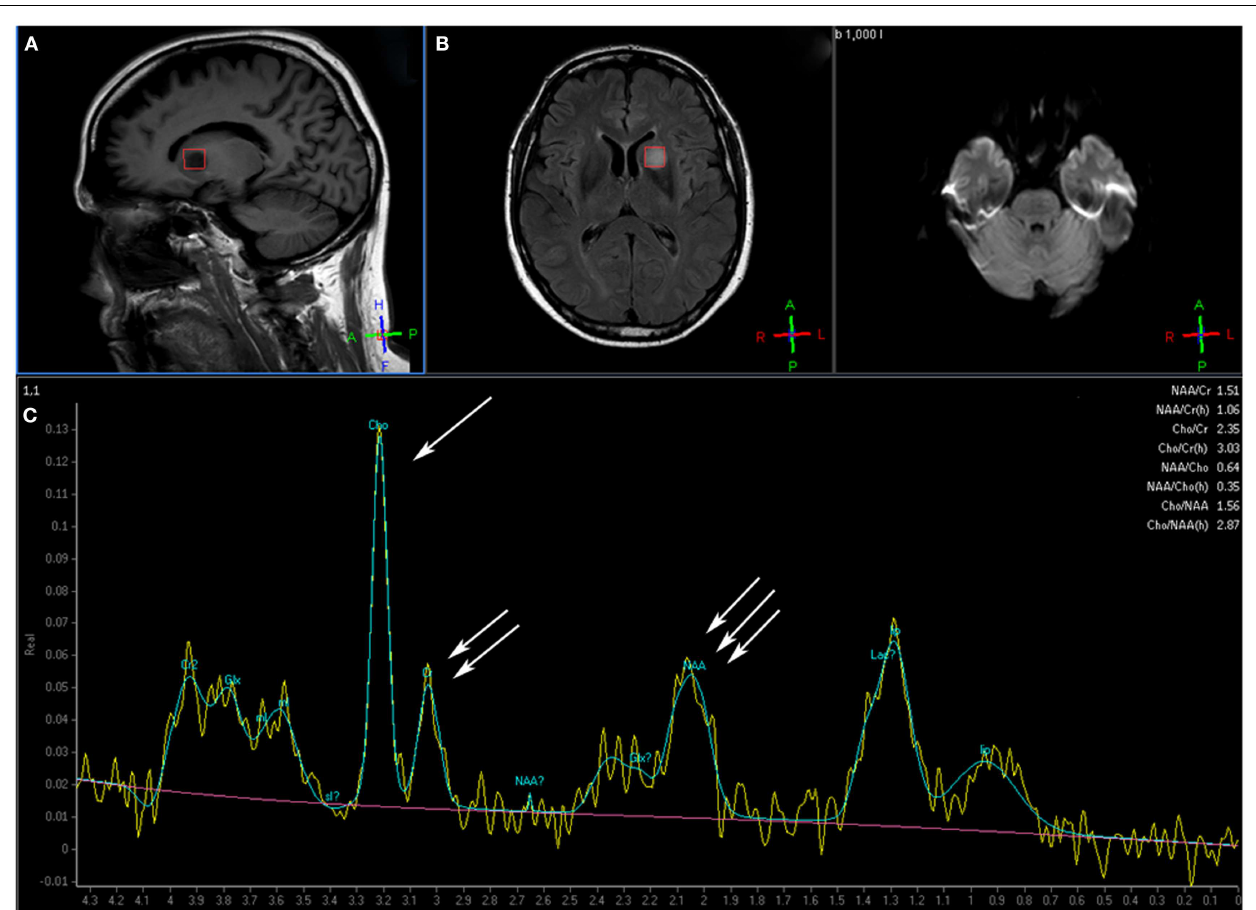
choline peak (single arrow) and decreased creatine (double arrow) and N -acetyl aspartate (NAA) peaks (triple arrow), which is the typical pattern for tumor (Images courtesy of Dr. Ashok Srinivasan, University of